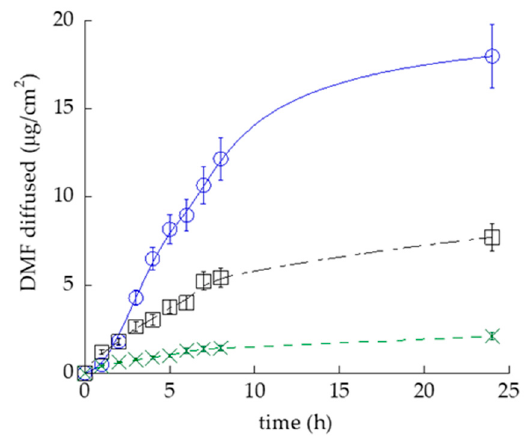
Figure 8. DMF permeability kinetics from TET 0 . 9 -DMF50 (o), TET 0 . 9 -DMF25-gel ( □ ), and TET 0 . 9 - DMF10-gel (x), as determined by Franz cells associated with Strat-M ® . Data are the mean of 6 inde- pendent experiments ± s.d.